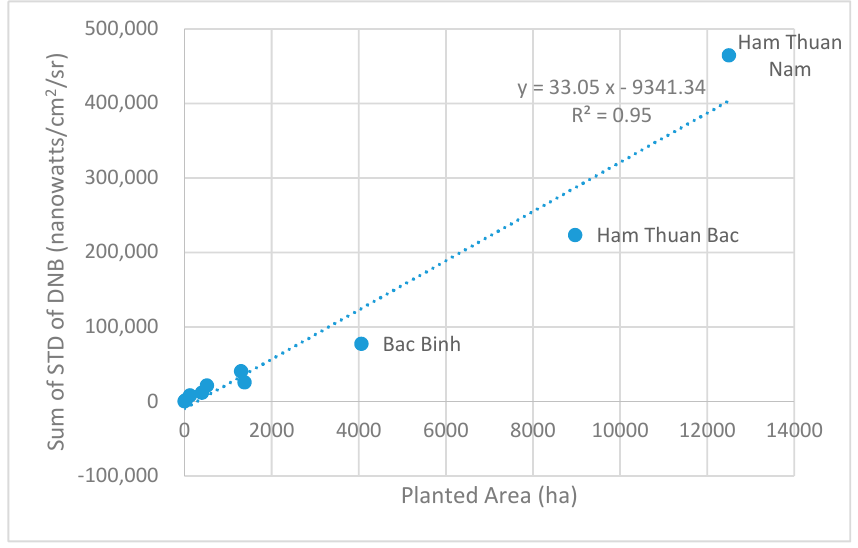
Figure 10. Pearson correlation between the sum of STD and the planted area of dragon fruit.